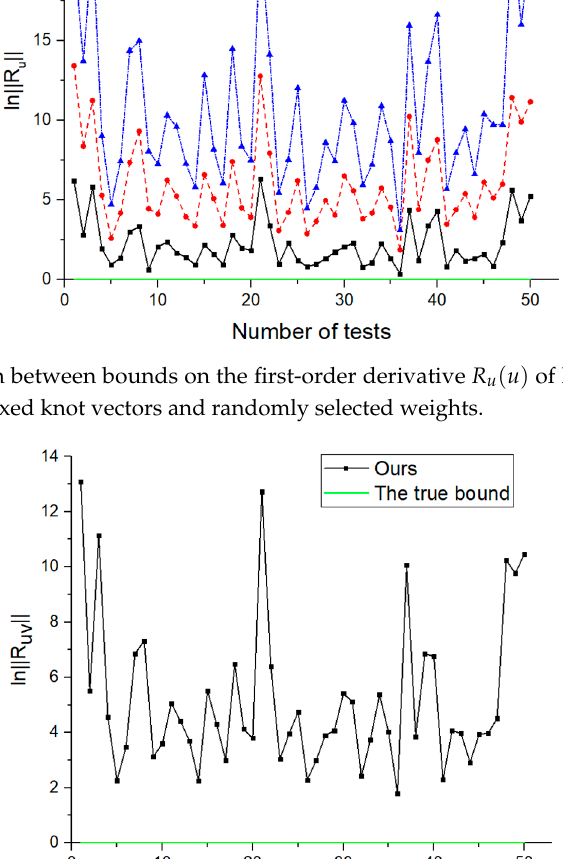
( ) R u of NURBS surfaces uv